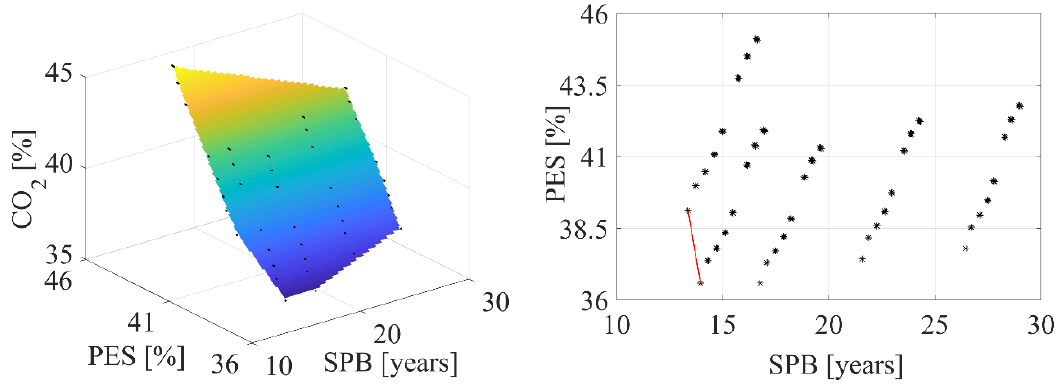
Figure 16. 2D Pareto frontier ( left ) and Optimal configuration research for Case ETC ( right ).